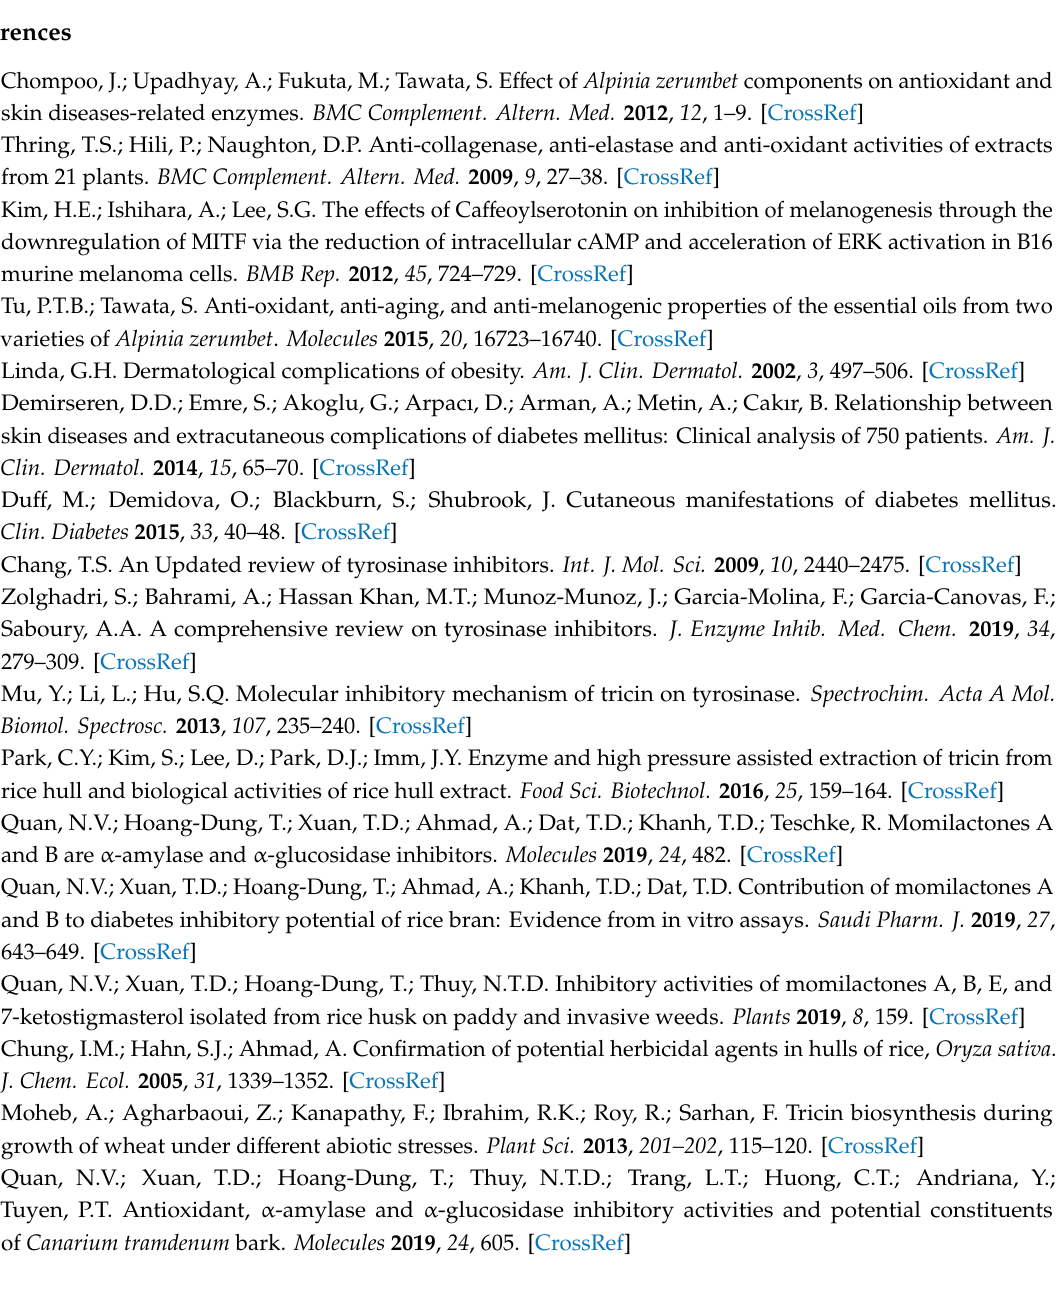
Figure S1: Extracted ion chromatography and mass spectrum of standard momilactones A (MA) and B (MB); Figure S2: Extracted ion chromatograms (EIC) and mass spectra (MS) of MA and MB in rice grain extracts by